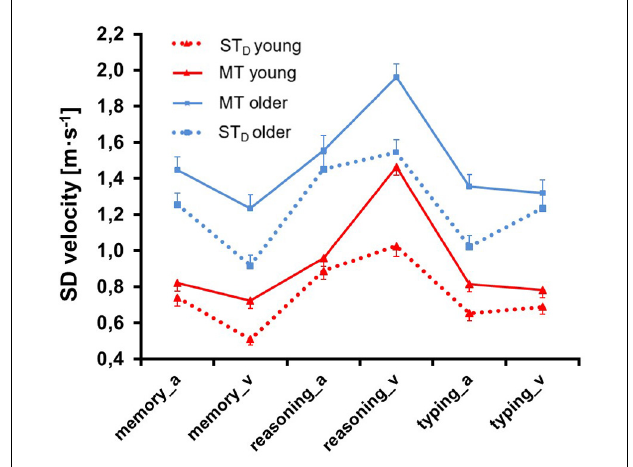
significant main effect for Condition: participants drove more slowly in MT compared to ST D ( F = 12.07, p = 0.00, η 2 df = 1, 122). The mean difference between MT and ST D was 1.35 ± 0.74 km/h. Slowing was least pronounced for the memory task and most pronounced for the reasoning task (significant ANOVA effect for Condition × Task), particularly when the latter was presented visually (significance for Condition × Modality, Task × Modality and Condition × Task × Modality). We further found a significant main effect for Group: older participants drove more slowly than young ones ( F = 15.62, p = 0.00, η 2 = 0.11, df = 1, 122). The mean difference between young p and older persons was 3.89 ± 0.41 km/h. We also observed